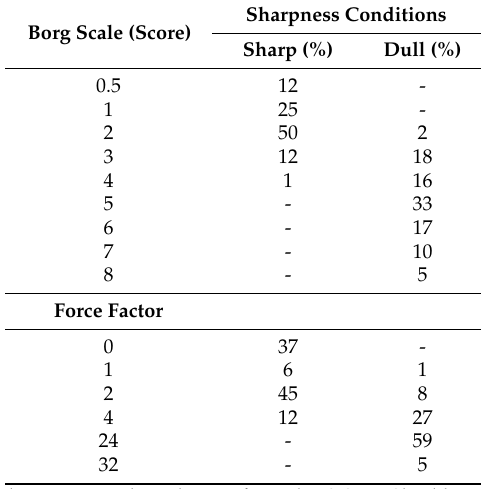
Table 5. Perceived exertion of workers in relation to the knife sharpness conditions.